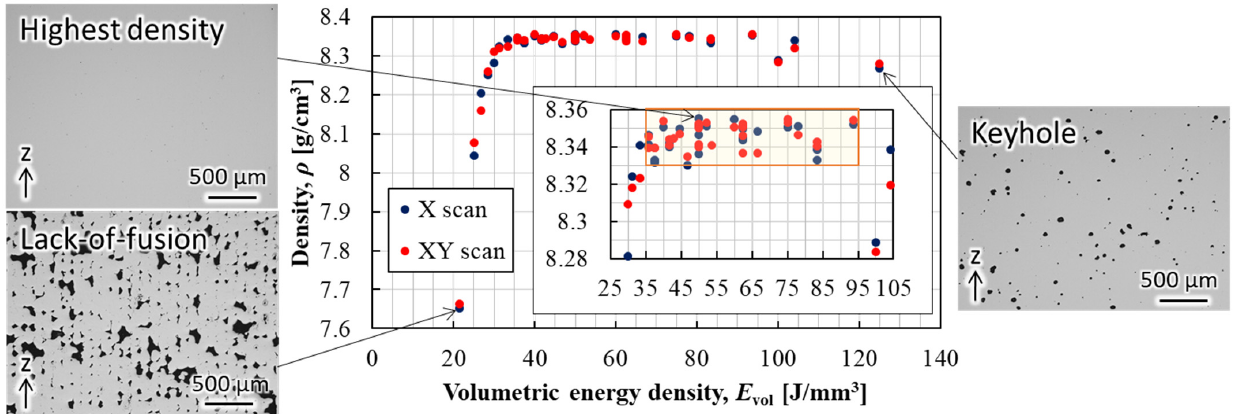
Figure 2. Relationship between the volumetric energy density and sample density. Optical microscopy images of the y–z cross-section of samples with the highest density, lack-of-fusion defects, and keyhole defects are also shown.